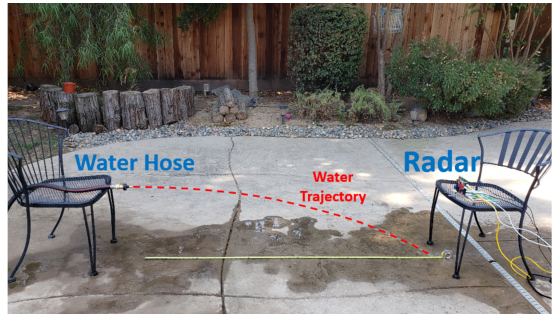
Figure 2. The water velocity measurement using a garden